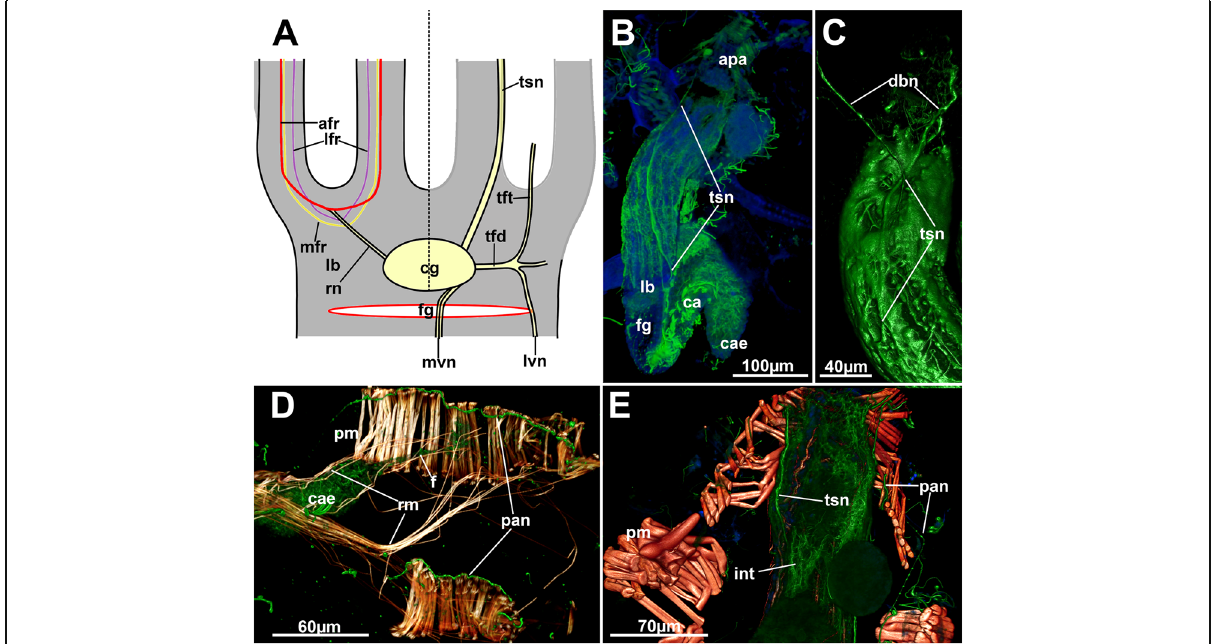
Fig. 6 Innervation of the tentacle sheath, apertural area and body wall of Hypophorella expansa . Acetylated alpha tubulin staining (green), f-actin (glow), nuclei (blue), CSLM, volume rendering. a Schematic drawing of the lophophoral base from the anal side showing peripheral innervation on the right side, and the anal tentacle innervation above the ganglion on the left. b Lateral view of a retracted polypide similar as in A. c Detail of neurite bundles branching from the tentacle sheath neurite bundle into the duplicature bands. d Parietal innervation on the frontal side of